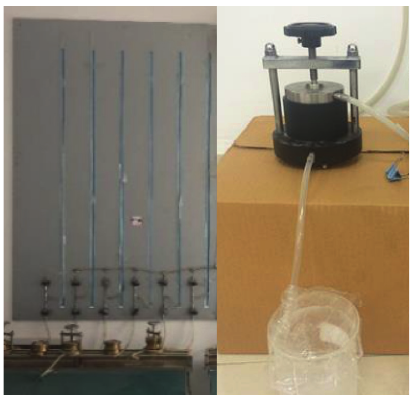
Figure 2: The variable head